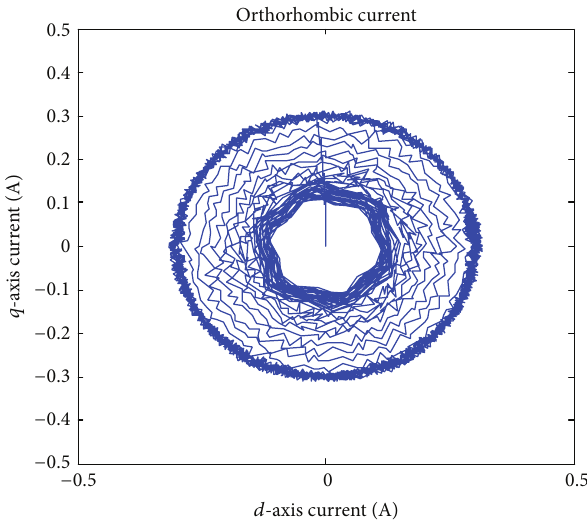
Figure 3: Unstable case of induction currents in 𝑑 and 𝑞 directions.